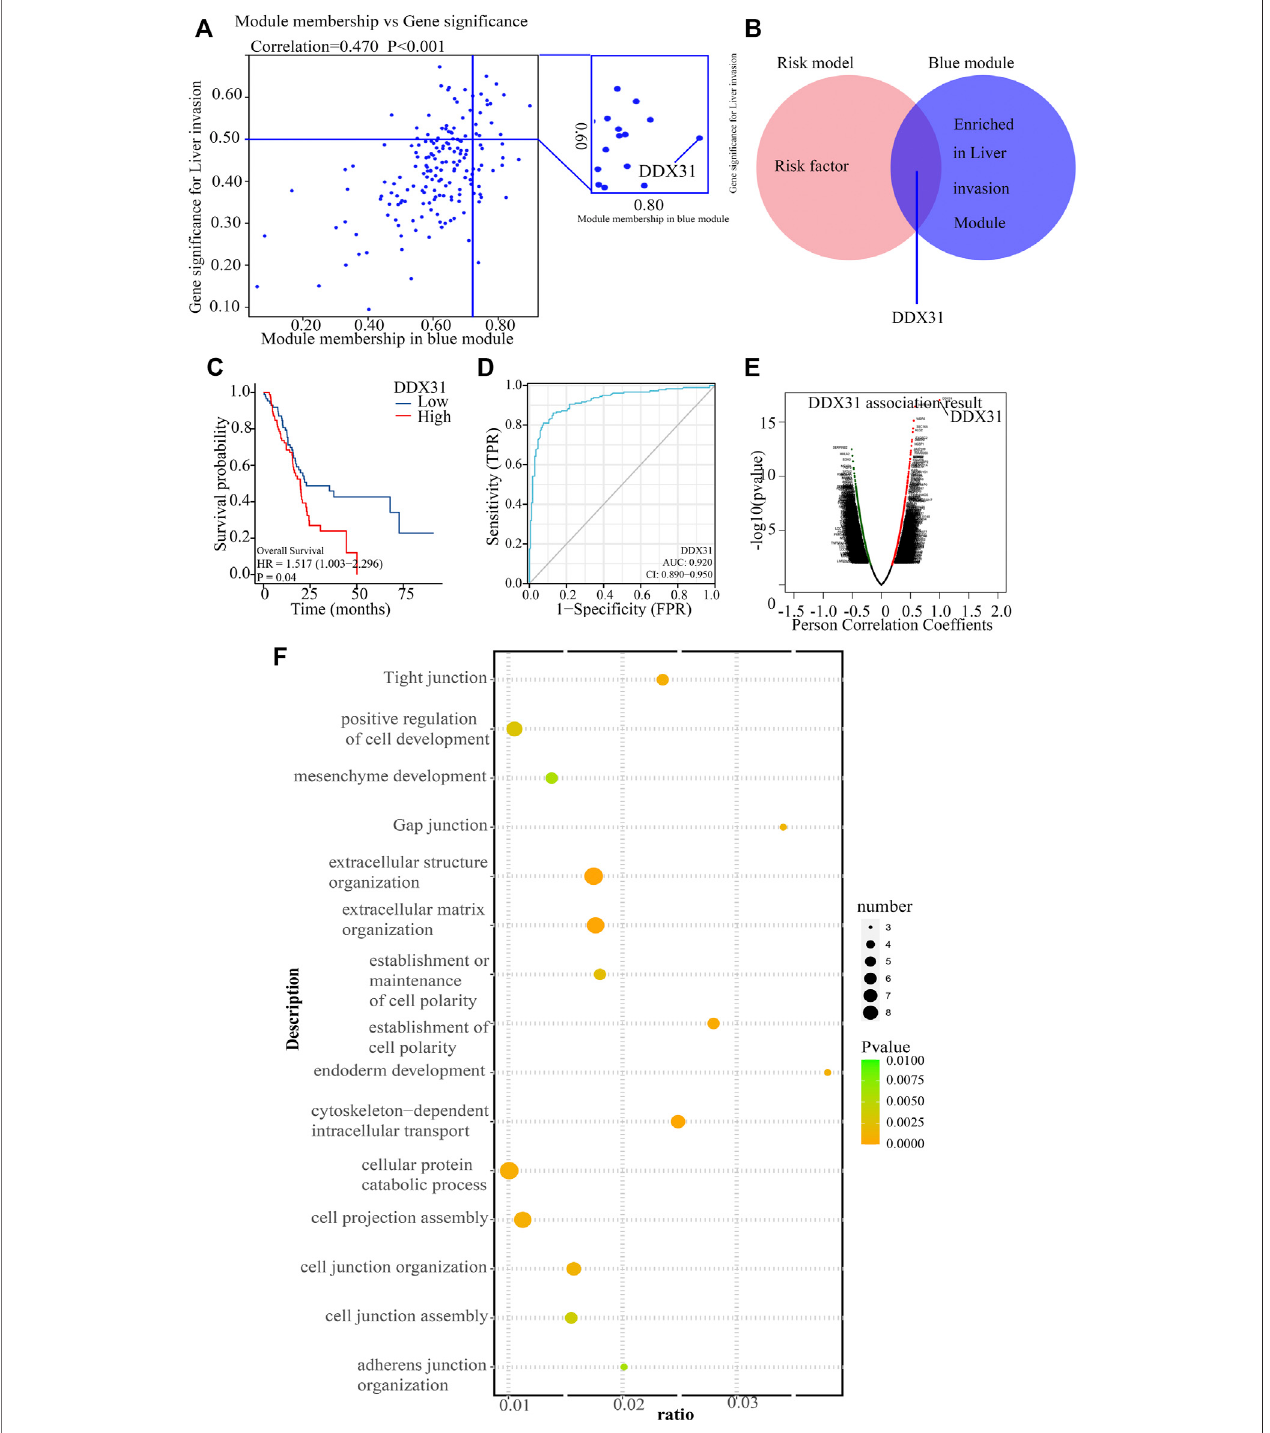
FIGURE 4 | Functional analysis of target gene DDX31 . (A) : The blue module containing DDX31 was correlated with PDAC liver metastasis. A scatter plot was mapped between GS and MM (blue module and liver metastasis) in PDAC patients. (B) : The intersected gene, DDX31 , was identi fi ed between risk factors in the risk model, and genes contained in blue modules with Venn diagram. (C) : Difference in survival K – M curve of DDX31 in PC. Red represents the high-expression group; blue representsthelow-expressiongroup.Pvaluelessthan.05isconsideredtobestatisticallysigni fi cant,andHR > 1hasthesigni fi canceofpromotingrisk;HR < 1has thesigni fi canceofinhibitingrisk. (D) :ROCpredictionanalysisof DDX31 inPC.AUCvalueisonthelowerright. (E) :Volcanoplotof DDX31 -positiverelatedgenes. (F) :GO enrichment analysis of positively correlated genes with DDX31 . (G) : KEGG enrichment analysis of positively correlated genes with DDX31 .